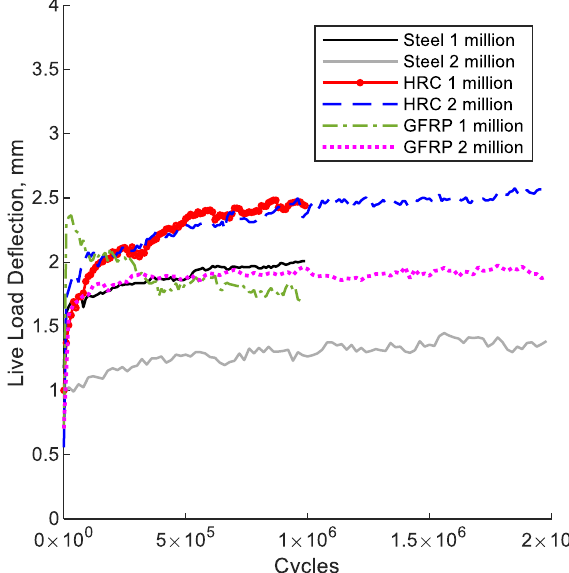
Figure 7. Deflection vs. No. of cycles.